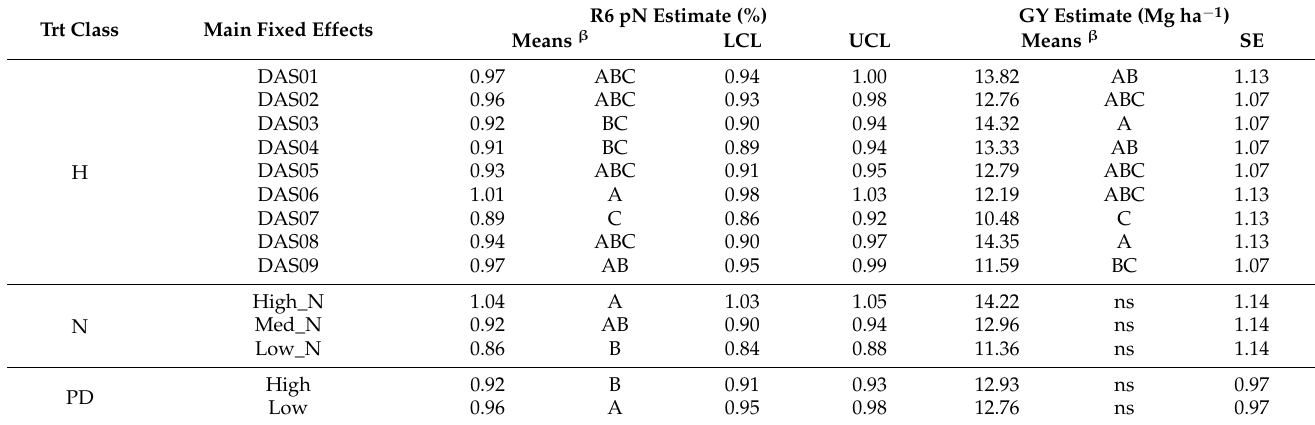
Table 4. Least square mean estimates of pN at R6 and grain yield (GY) for main fixed effects of hybrid (H), nitrogen (N), and plant density (PD). Hybrid means with different letters are significantly different.